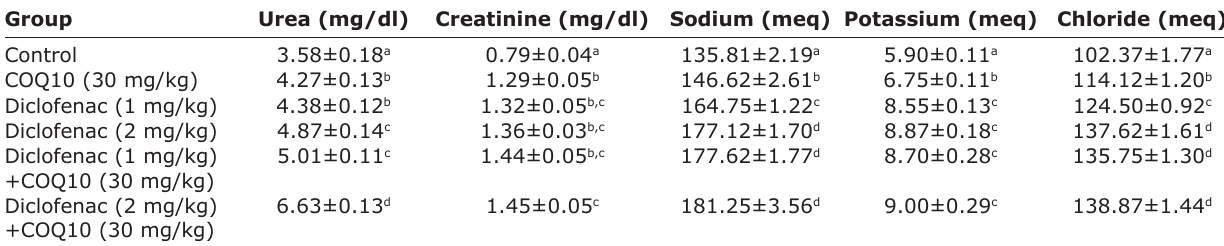
Table-3: Effect of COQ10 and diclofenac on serum urea, creatinine, sodium, potassium, and chloride (n=8).